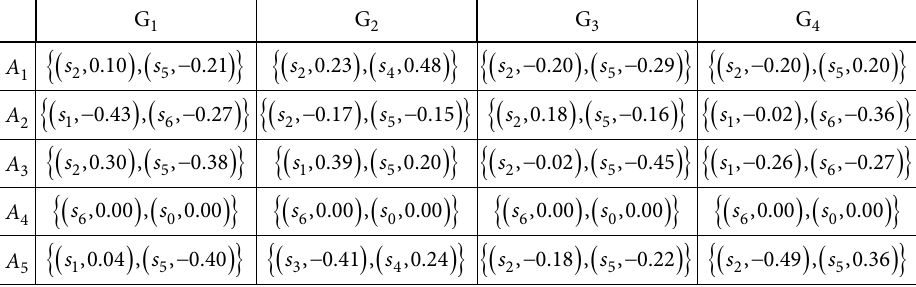
Table 9. Collective weighted assessing matrix with 2TLPFNs